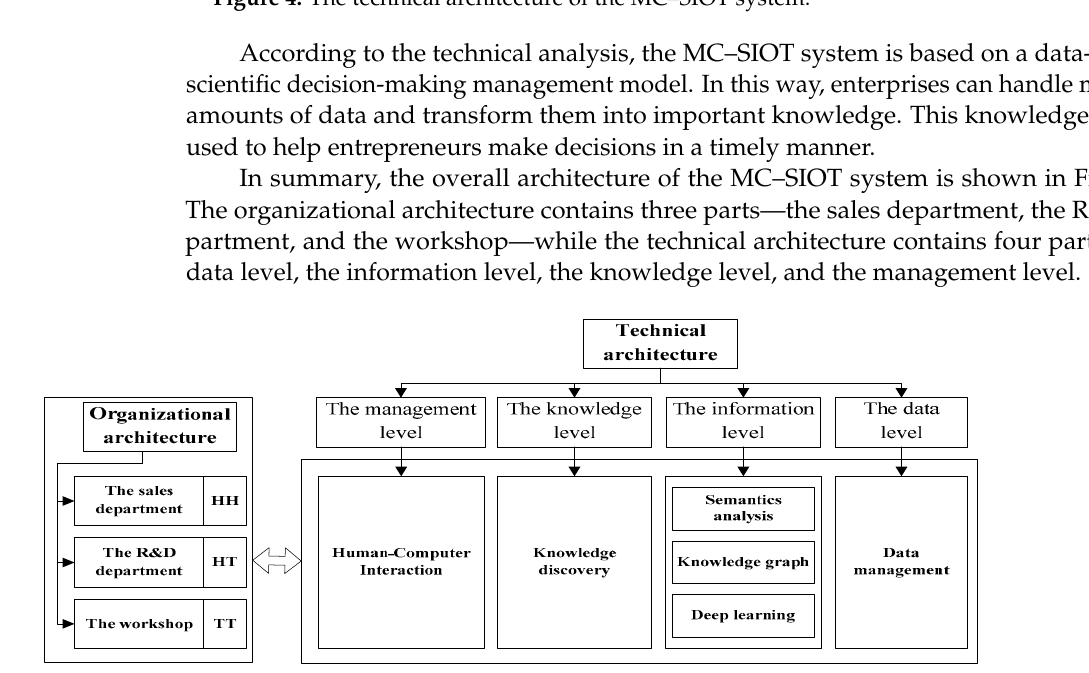
Figure 4. The technical architecture of the MC–SIOT system.